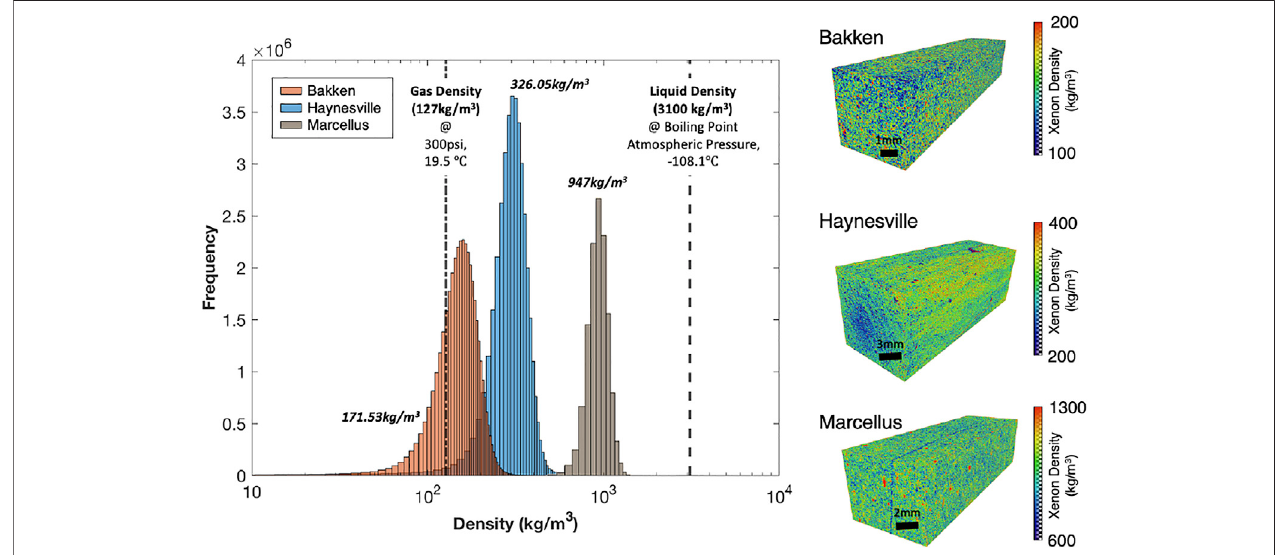
FIGURE5 | Cross-plot ofcomputed in-situ xenon density against the corresponding porosity for the (A) Bakken, (B) Haynesvilleand (C) Marcellusshalesamples.